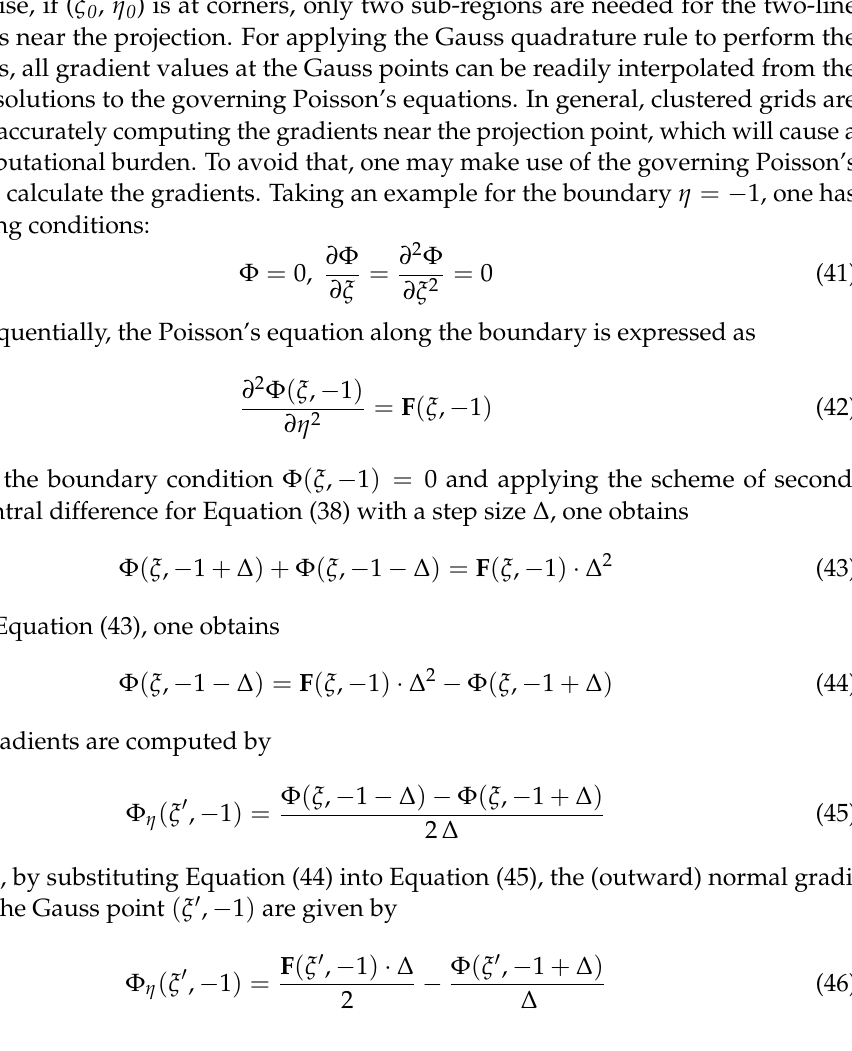
Figure 3. Fluctuations of the normal gradients on the boundary of a typical example for ( a ) Φ ( 2 ) ( b ) Φ (cid:48) η